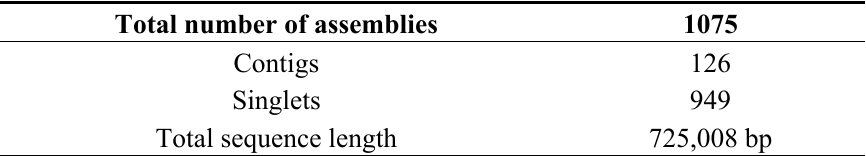
Table 1. Summary of the